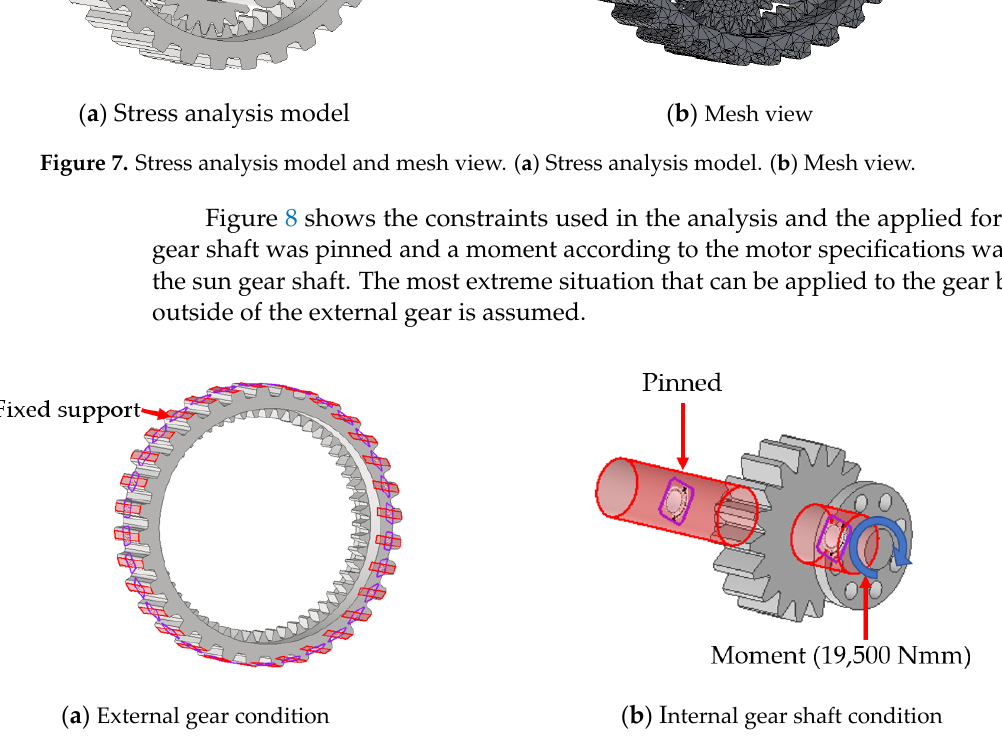
Figure 8. Condition of stress analysis. ( a ) External gear condition. ( b ) Internal gear shaft condition.